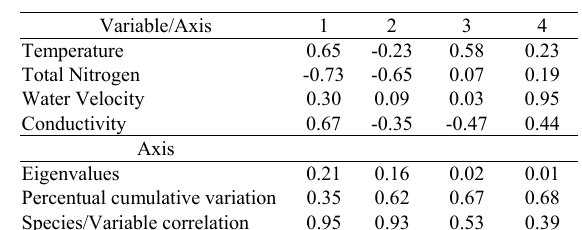
Table 4. Results of Canonical Correspondence Analysis (CCA) on fish guild biomass and selected environmental variable.Variable/ Axis = Biplot scores for constraining